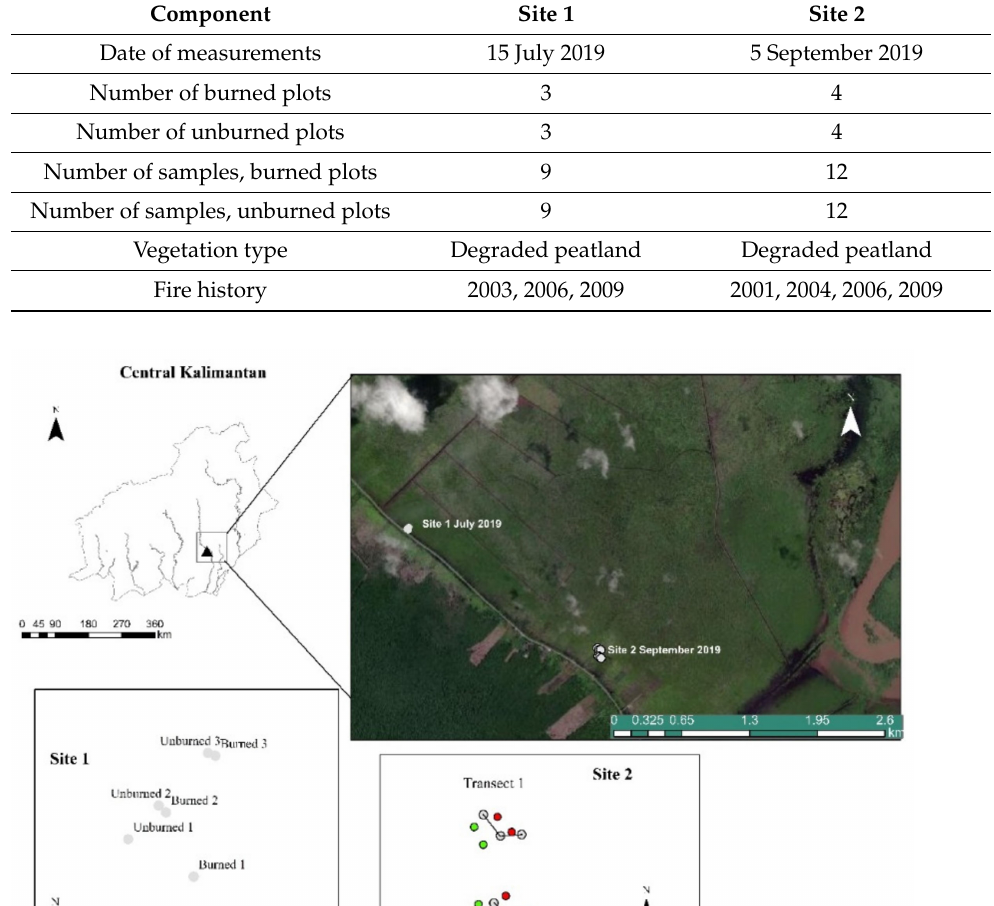
Table 1. Sampling design at Site 1 and 2 in burned and unburned treatments in degraded peatlands.